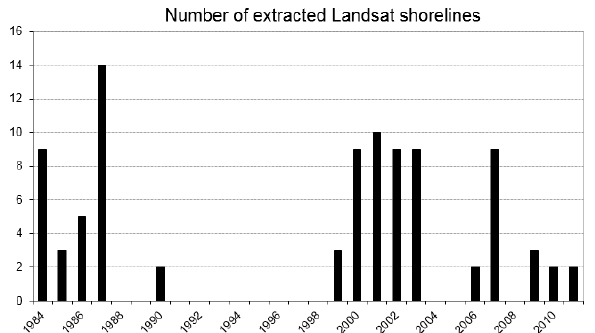
Figure 3. Temporal distribution of high precision and Landsat shorelines during the defined periods: 2006-2007 and 2009- 2010.